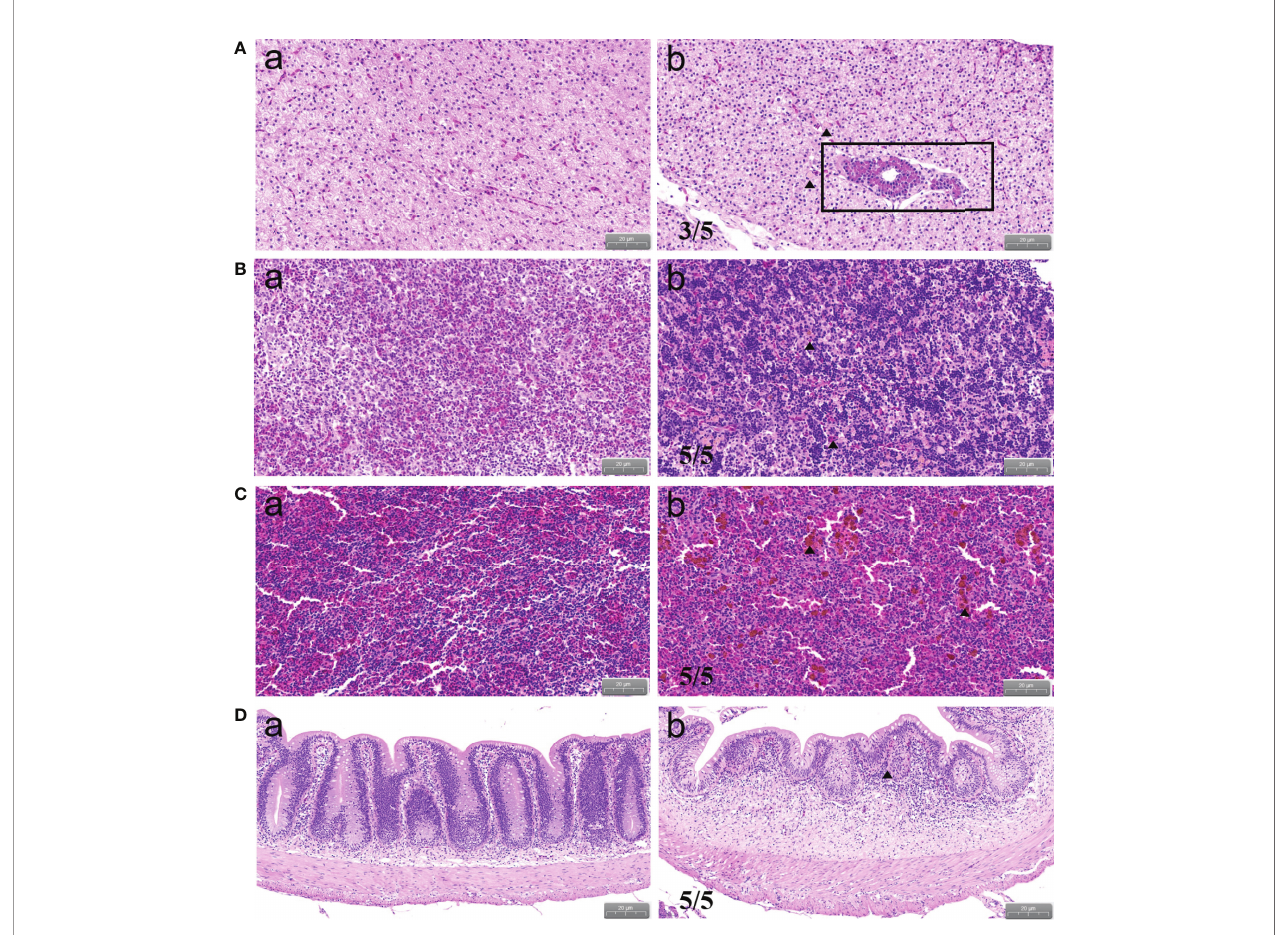
FIGURE 4 | Histopathological changes in C carpio tissues after P. shigelloides challenge. (A) Infected liver. (B) Infected head kidney. (C) Infected spleen. (D) Infected intestine. Pictures of typical symptoms are shown. Scale bar of A, B, and C = 20 m m. Scale bar of D = 50 m